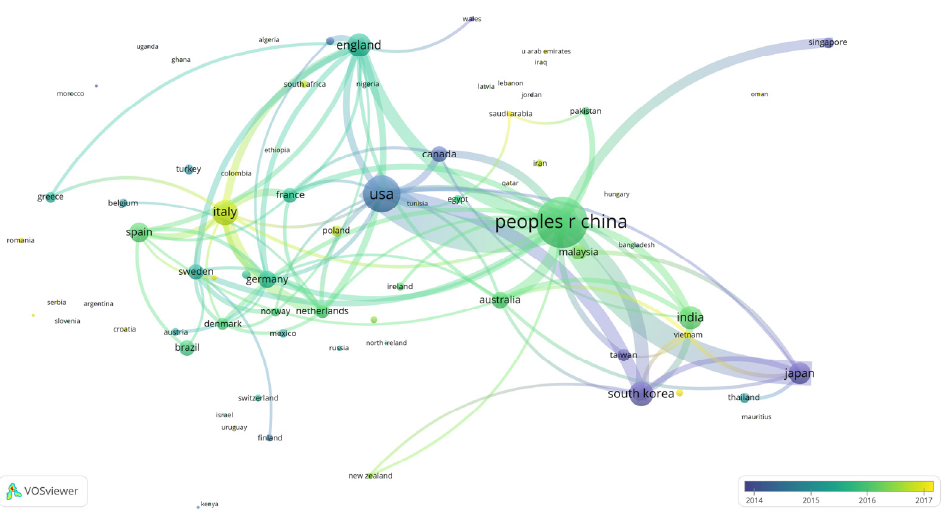
Figure 3. Mapping knowledge domains of coauthoring countries/regions in FW